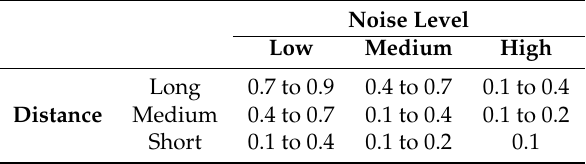
Table 3. Approximations of the influence radius levels depending on the distance and